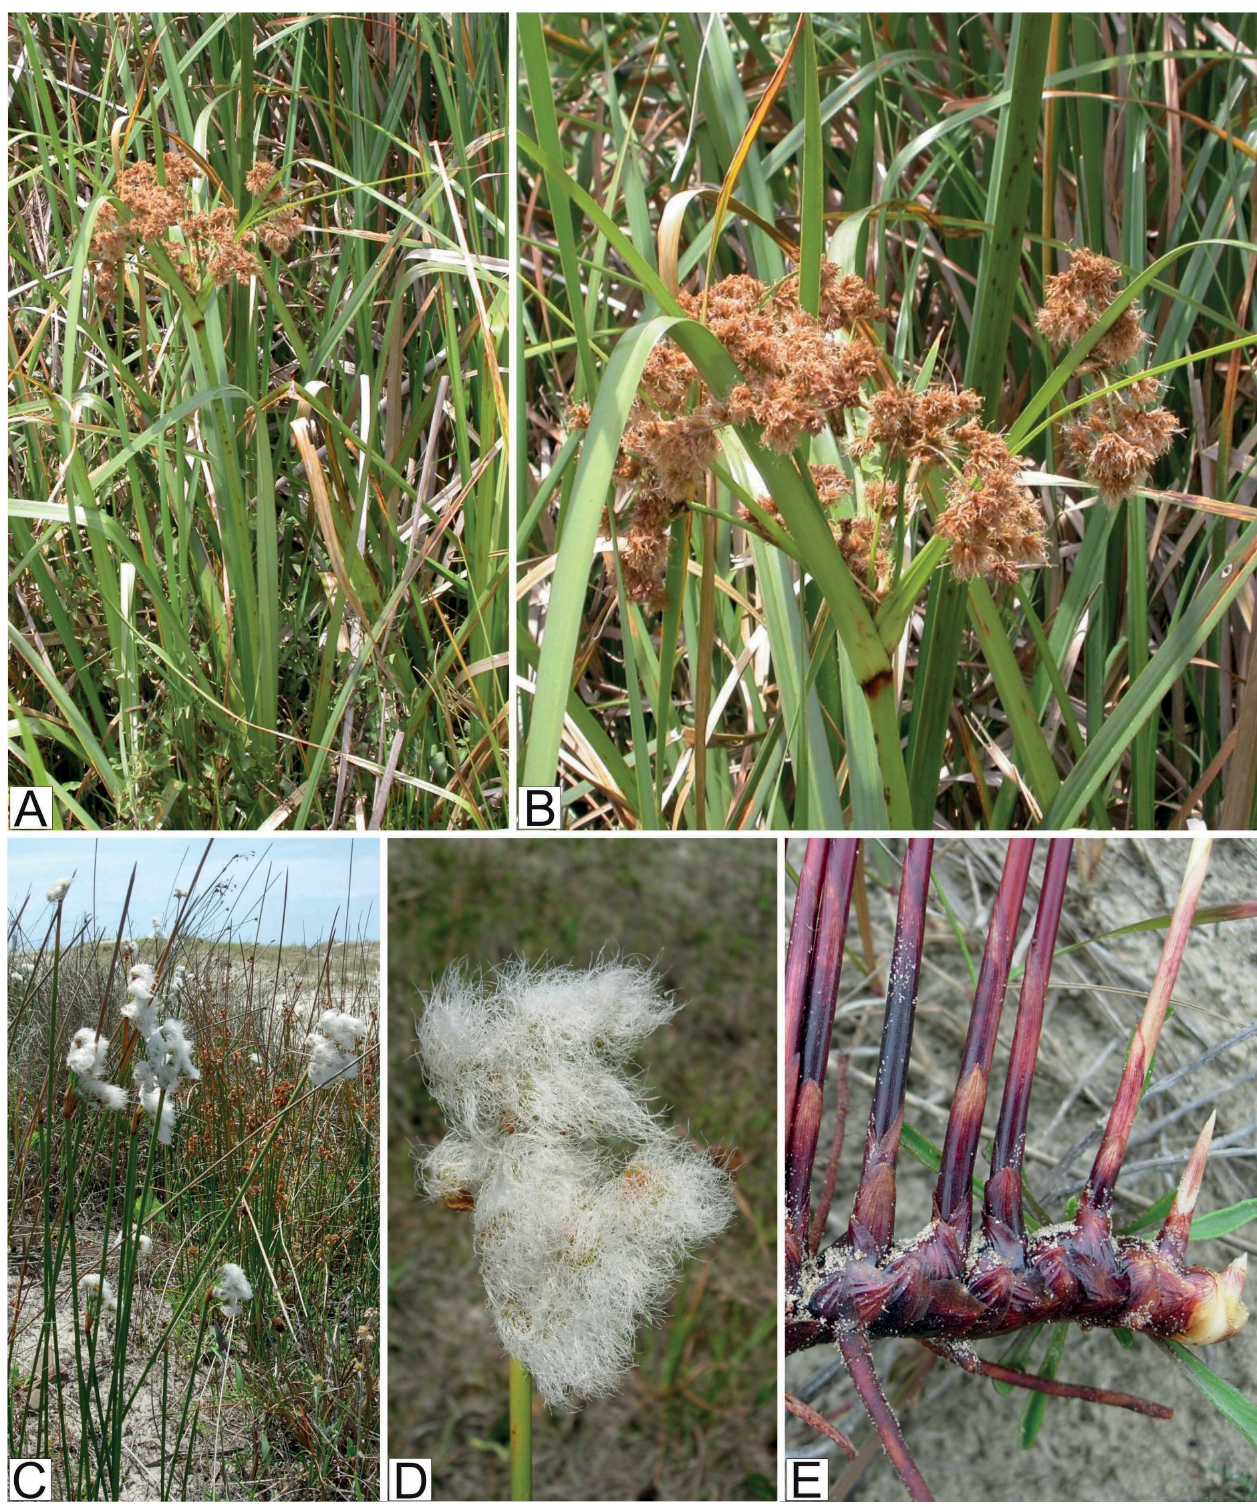
Figure 1 – A – B . Cyperus byssaceus. A . Habit. B . Inflorescence with reddish brown elongated stamen filaments. C – E . Cyperus trigynus. C . Habit. D . Inflorescence with hyaline white elongated stamen filaments. E . Rhizome. Photographs by Rafael